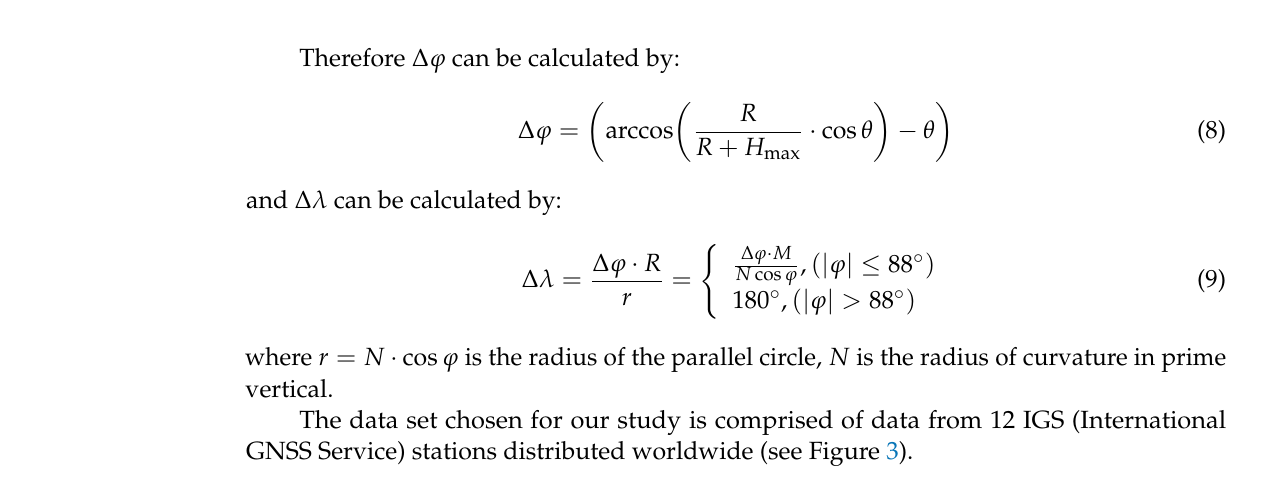
Figure 2. The ray-tracing land cover area.